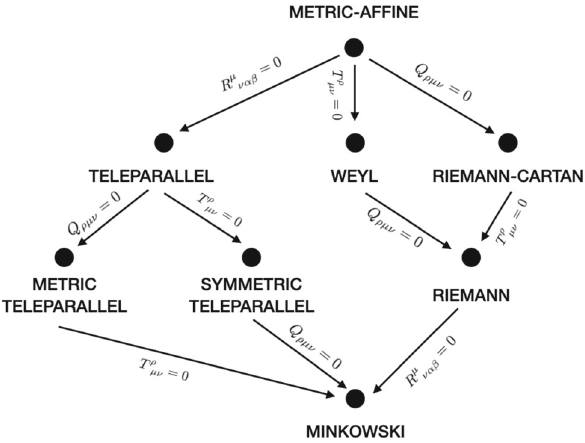
Fig. 1 A possible classification of theories emerging from metric- affine gravity